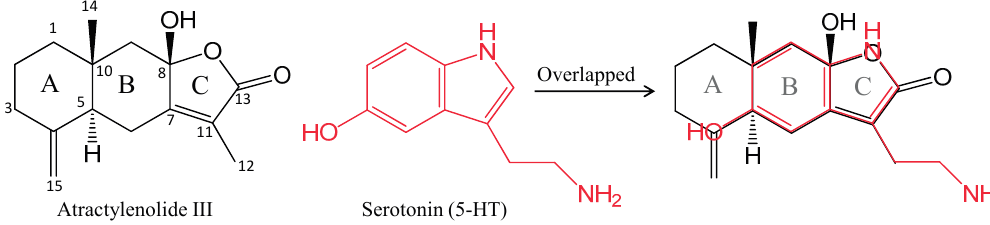
Figure 4. Postulated active site in the chemical structure in atractylenolide III compared to serotonin